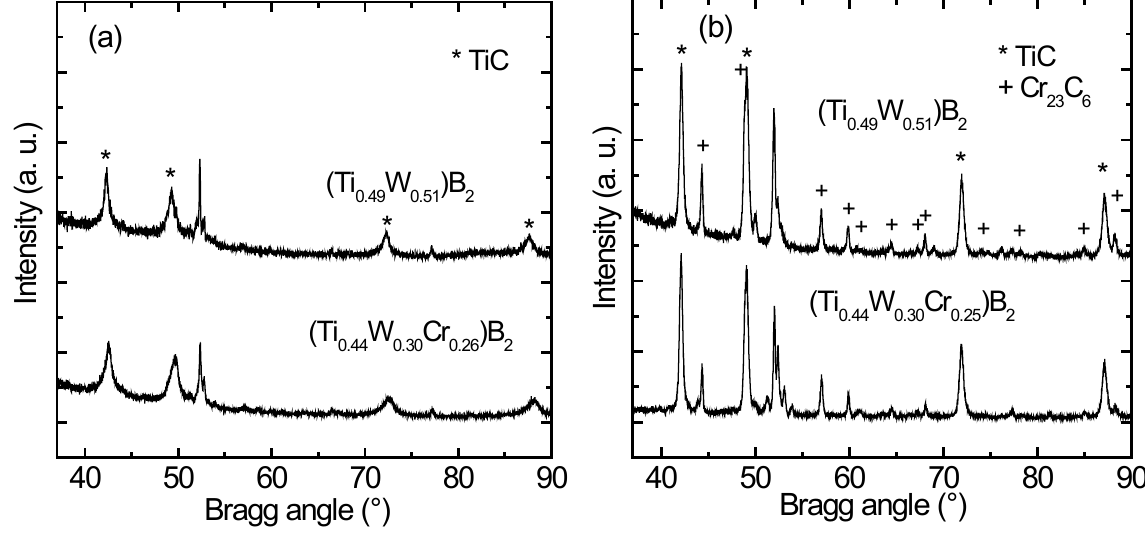
Figure 3. GI-XRD patterns of (Ti annealing for 0.5 h at ( a ) 900 °C and ( b ) 1100 °C. The precipitated phases of type TiC and C are indicated. Peaks referring to the steel substrate are Cr 23 6